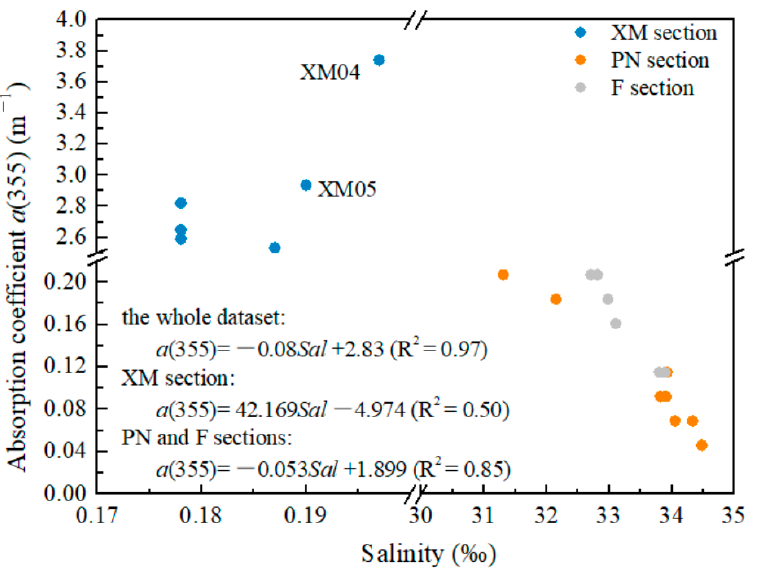
Figure 4. Relationship between salinity and a ( 355 ) . Strong correlations for the datasets of sections PN and F and for the entire dataset.